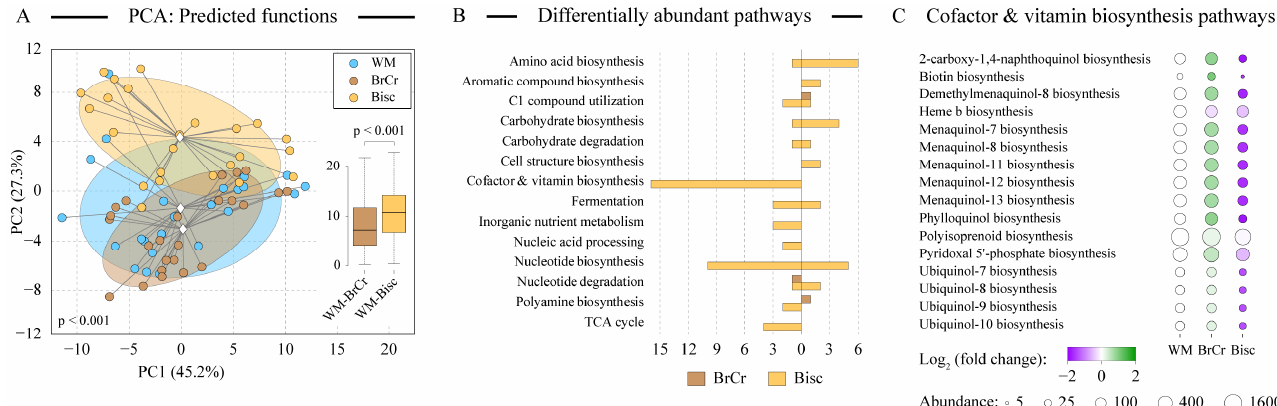
Figure 4. Analysis of predicted functional capacities of microbial communities. Panel ( A ) depicts the results of the principal components analysis (PCA) of predicted metagenome-encoded microbial functions. The percent of dataset variability explained by each axis is shown in parentheses in axis titles. Individual samples are colored as shown and are linked to group centroid. Group clouds show areas of three standard errors around the group centroid (diamond). The distributions of pair-wise distances in PCA space between positions of samples from different groups are shown as boxplots. Statistical significance was calculated by Welch’s t -test. Panel ( B ) visualizes the numbers of statistically differentially abundant (DA) pathways in the predicted metagenomes of Bisc and BrCr grown communities compared to the WM communities. Predicted functional genes were assigned to pathways and pathway groups based on MetaCyc database [33]. Only pathway groups with at least two DA pathways are shown. There were also 14 pathway groups with a single DA pathway (13 for Bisc comparison and 1 for BrCr comparison). Pathways that increased in predicted genome encoding in Bisc or BrCr samples in comparison to WM samples are shown to the right, and pathways that decreased—to the left side from zero. The prevalence of individual pathways within cofactor and vitamin biosynthesis pathway groups is displayed in panel ( C ). The size of each circle is proportionate to the geometric mean of PICRUSt2-predicted pathway gene abundances among metagenomes in that sample category. Circle color represents the magnitude of the ratio of pathway abundance between BrCr or Bisc samples and the baseline WM community.